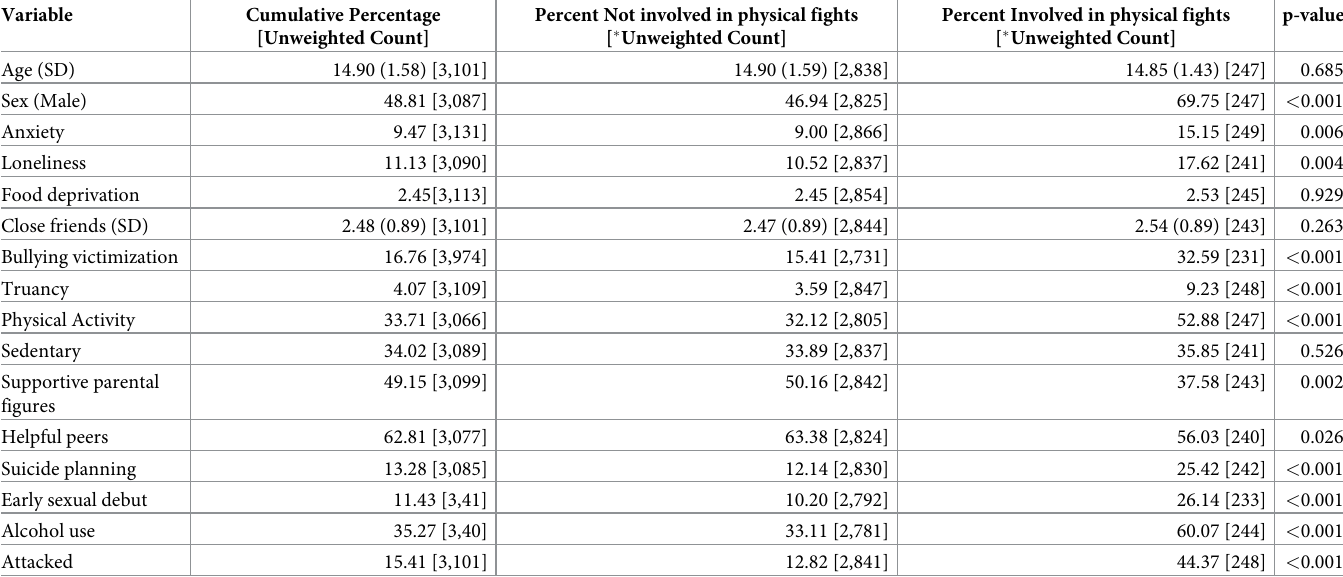
Table 2. Cumulative proportion of factors in school-attending adolescents in Paraguay, GSHS